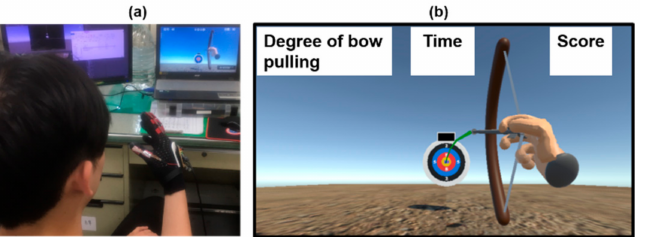
Figure 10. Demonstration of the virtual archery game. ( a ) The user is playing the virtual archery game. ( b ) The bow is pulled.